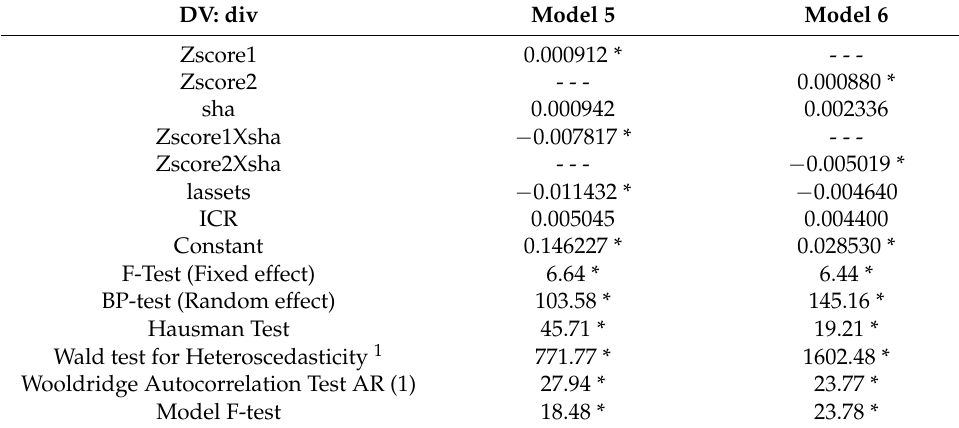
Table 5. Interaction Models Results for moderating